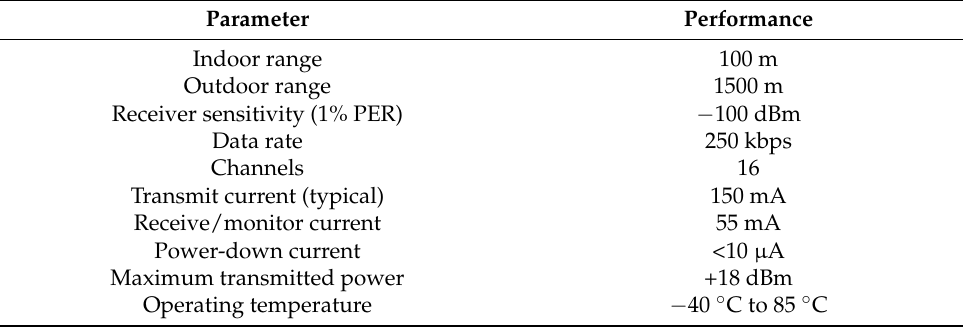
Table 1. Basic specifications of Xbee-Pro Radio Frequency Module.